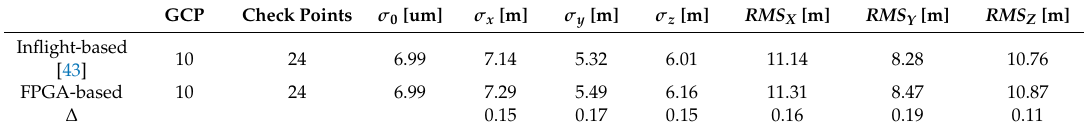
Table 8. Accuracy of ground coordinates calculated by inflight-based and FPGA-based